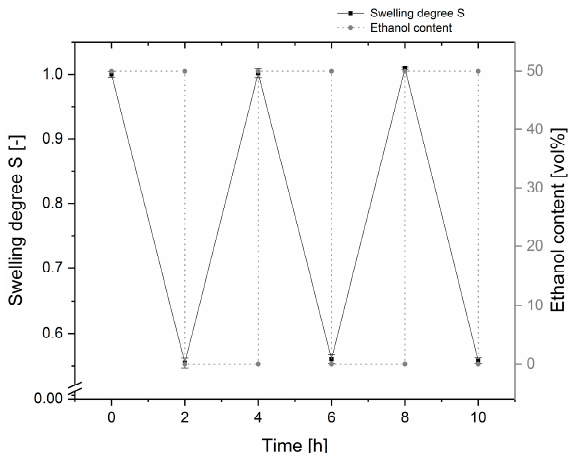
Figure 4. Reversible hydrogel swelling of the polyacrylamide (PAM) hydrogel versus ethanol content of the solution. The swelling degree S shows a decrease of about 45% between distilled water and a 50 vol% ethanol solution.